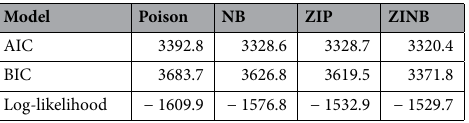
Table 6. Model selection criteria for the count regression